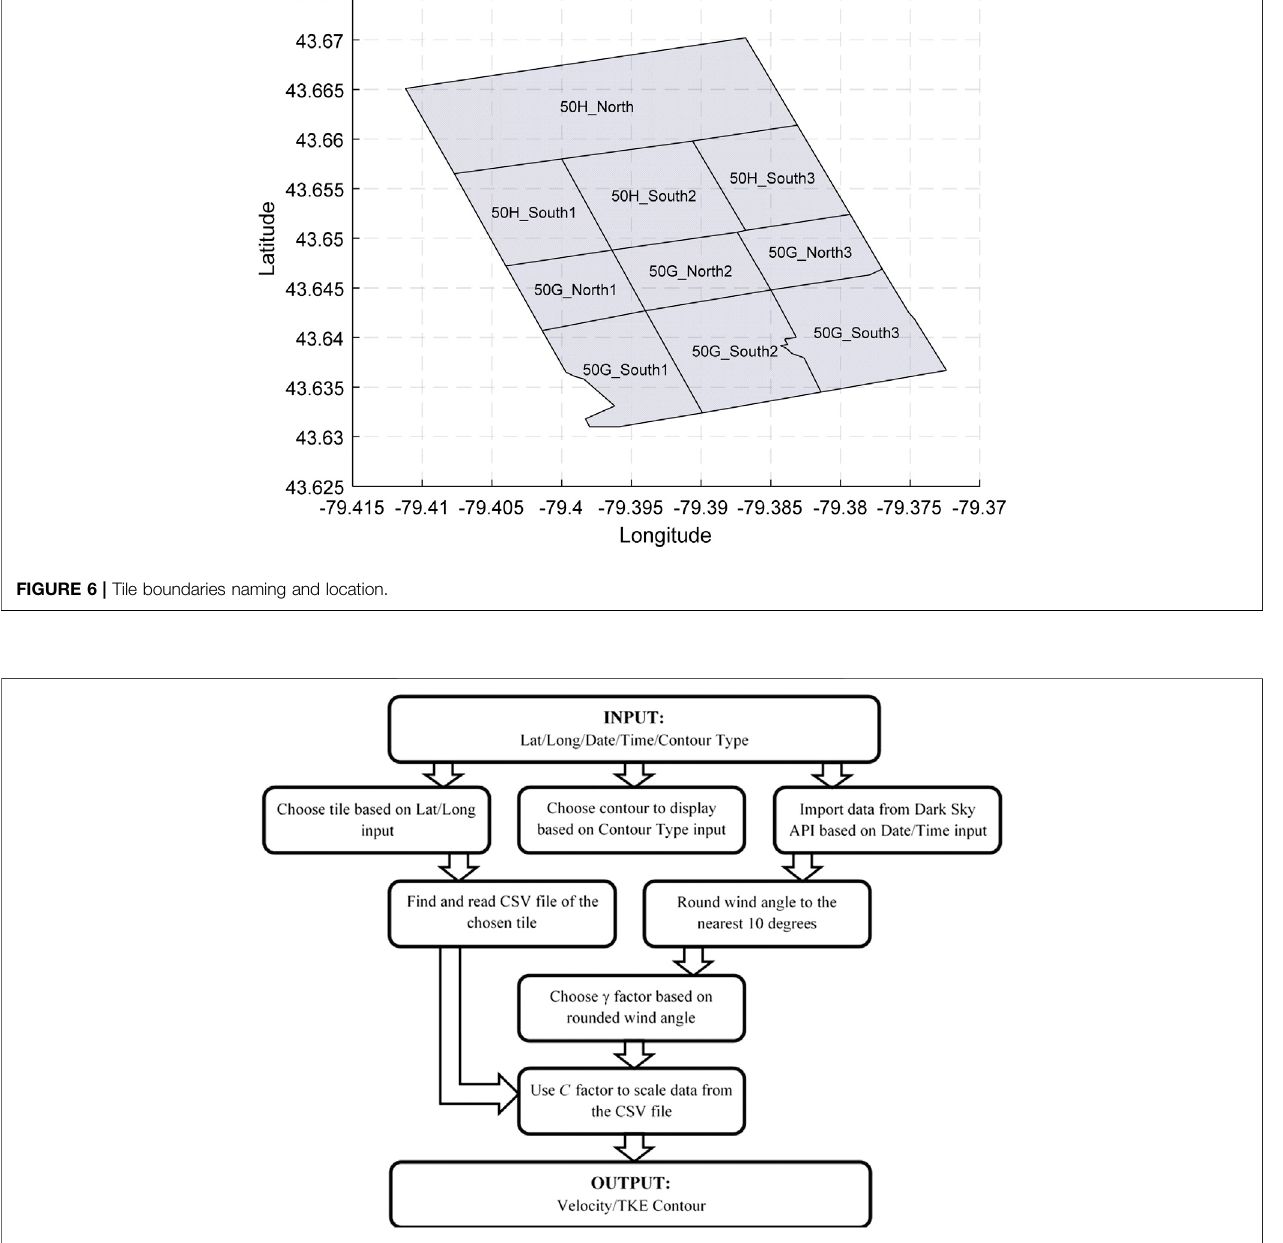
FIGURE 7 | Flowchart of the developed